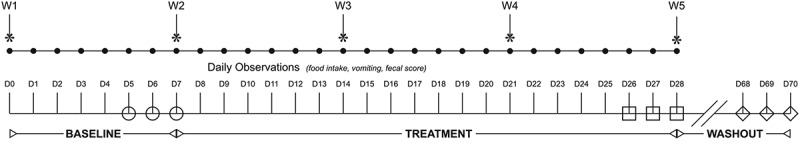
Study design, duration, observations, and sampling flowchart.The study spanned 670 days (D1–70) and was broken into three study periods: baseline (D1–D7), treatment (D8–D28), and washout (D29–70). Cats were randomized to receive 75 mg clindamycin PO followed 1 h later by either a placebo or synbiotic once daily during treatment. Food intake, vomiting, and fecal score were recorded daily (•) and weight (W) weekly (*) by an individual blinded to treatment group. From the center portion of each first morning naturally voided fecal sample for each cat, 2 g were collected once daily on the last 3 days of each study period: baseline (open circles), treatment (open squares), and recovery (open diamonds). Each sample was subdivided into two aliquots, with each aliquot placed into a 2 mL cryovial and immediately frozen at –80ºC pending completion of data collection.